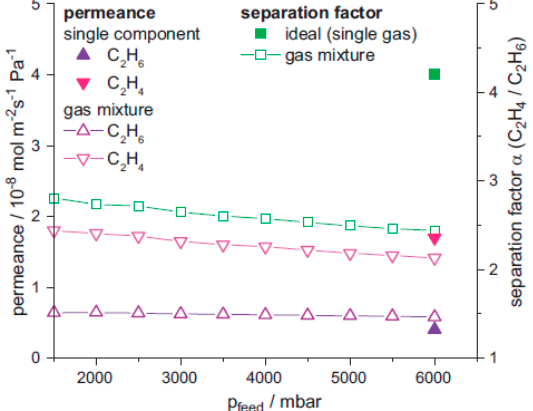
Figure 62. Permeances and separation factors at T = 298 K of the ZIF-8 membrane as shown in Figure 1 for ethene and ethane as pure component as well as in equimolar mixture for different feed pressures. The mixture measurements were carried out using the Wicke–Kallenbach technique (partial pressure of the C 2 component ≈ 0 at the permeate side) while for the single gas measurement no sweep gas was used (partial pressure of the C 2 component ≈ 1 bar at the permeate side). For gas mixtures, the permeances were calculated at T = 293.15 K and p = 1.013 bar from the applied partial pressure difference (for equimolar composition this is 1/2 feed pressure) and for pure component from the total pressure difference (p = 5 bar) (adapted with permission from ref. [145]).